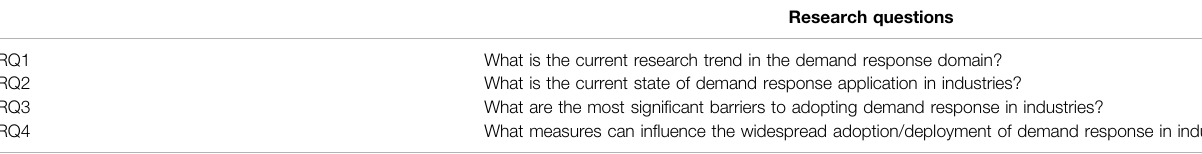
TABLE 2 | Research questions of the paper.